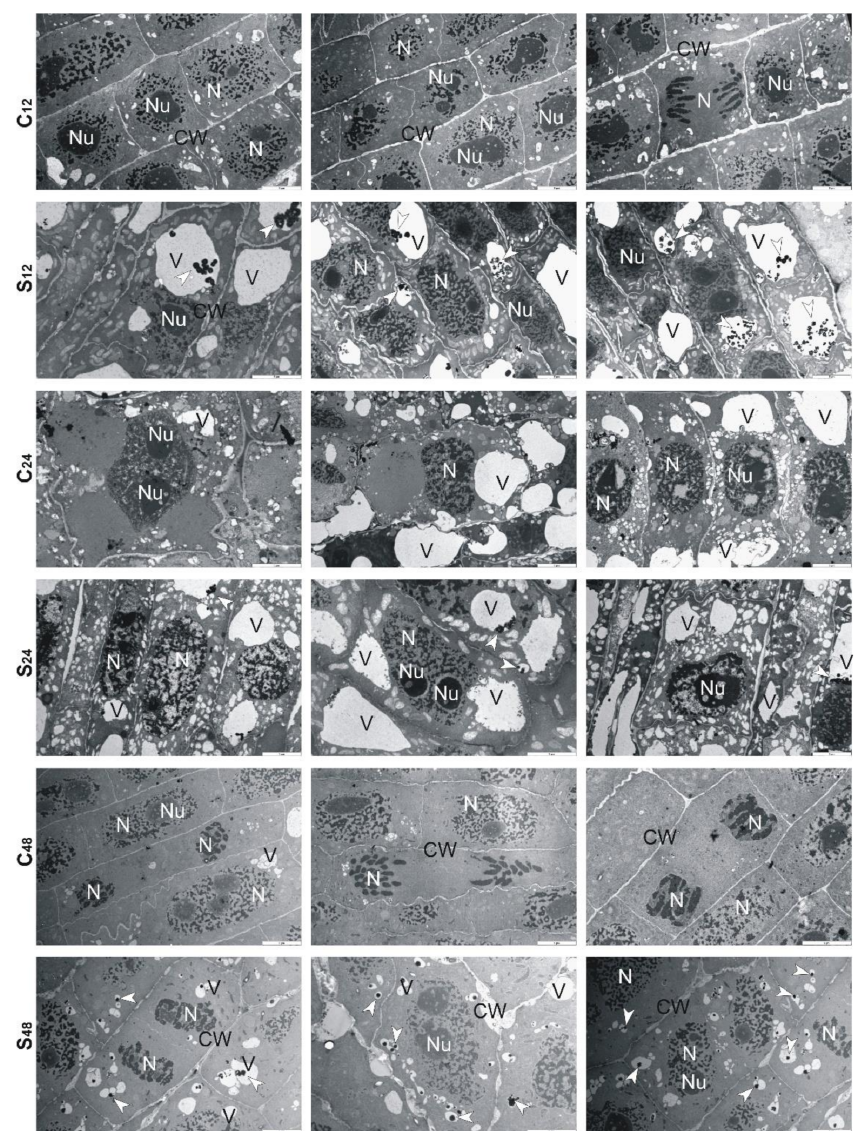
Figure 7. Representative results of the ultrathin sections taken from the roots of tolerant triticale cv. “KWS Trisol” at 12, 24 and 48 h after treatment with Al 3+ (0.59 mM) (S) and in untreated plants (C). Caption: arrowheads: electron-dense precipitate, CW: cell wall, N: nucleus, Nu: nucleolus, V: vacuole. Bar= 5 µ